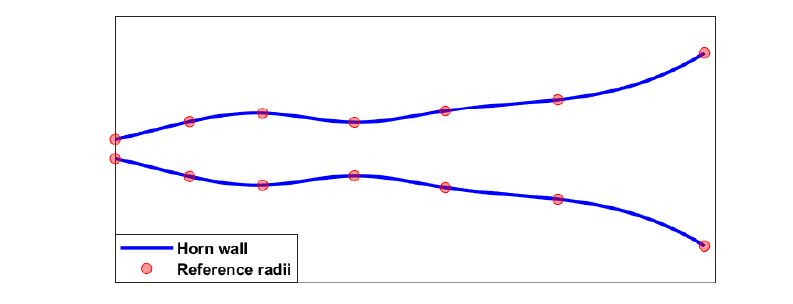
Figure 12. Representation of a spline-profile